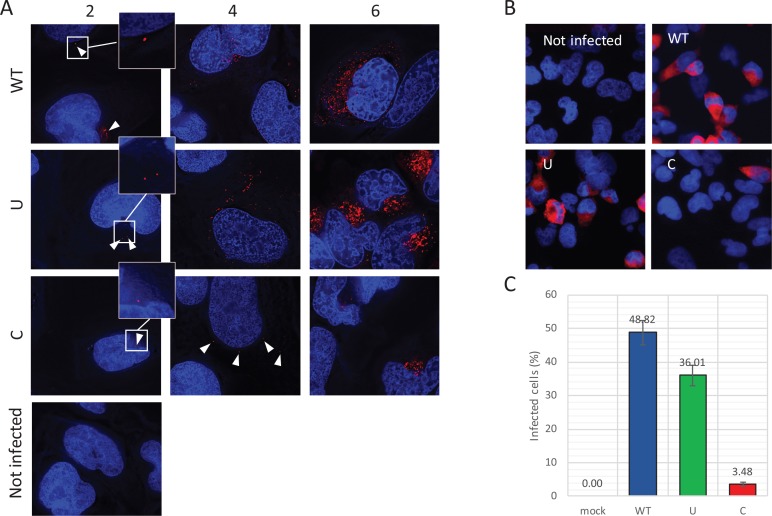
Reduced infectivity of E7 with increased UpA and CpG dinucleotides.(A) RD cells were infected with E7 variants with R2 of either wild type (WT), UpA high (U) or CpG high (C) composition at 1000 RNA copies/cell. Cells were fixed at indicated times post infection and stained with Stellaris probes against an unchanged region of the E7 genomic RNA (red) and the nucleus was stained with Hoechst 33342. To clearly capture E7 genomes at 2 hpi and the 4 hpi E7_R2_C sample, images of the red channel were taken with an exposure time of 1 s. Arrows are placed to indicate the location of the E7 genomes and enlarged images are displayed. For the other samples exposure time was reduced to 0.25 s. Images were Z-stacked and deconvolved with SoftWorx Deltavision software. (B, C) RD cells with indicated R2 composition that contained genomic E7 RNA were photographed at six hpi. Per experiment, each sample was photographed three times with identical exposure times (representative images panel B). (C) Bars represent the mean of three independent experiments and error bars one standard error of the mean. For each condition the total cell count n > 500.